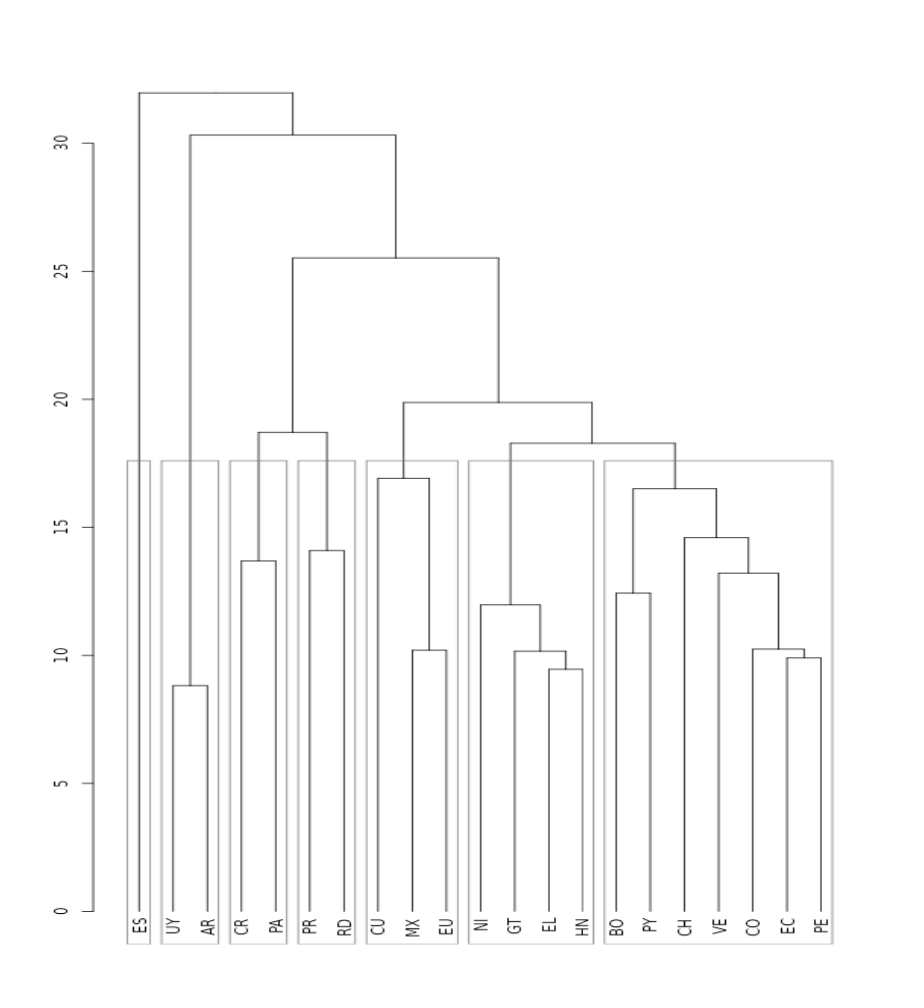
Figure 5. Hierarchical Clustering Dendogram Using the 148 Highest Ranked SVM